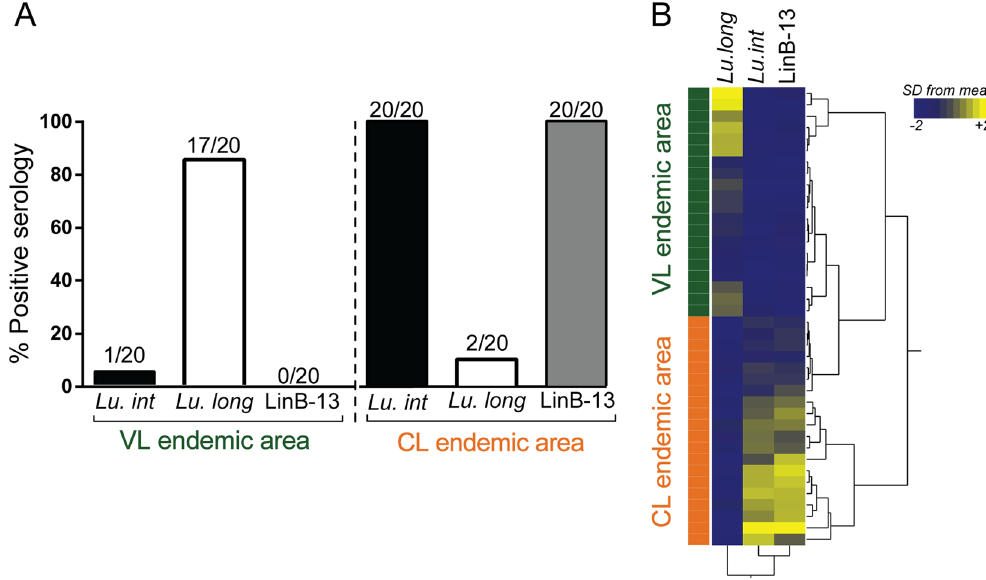
Figure 5. Cross-reactivity between serological responses to LinB-13 and to Lu. longipalpis saliva. Serum samples (n = 20) from residents of a CL endemic or of a VL endemic area were tested by ELISA against Lu. intermedia SGS, Lu. longilpalpis SGS and LinB-13. ( A ) Number of subjects with positive serology to each antigen, comparing the CL and the VL endemic areas. ( B ) Heat map depicting the pattern of Lu. intermedia SGS, Lu. longilpalpis SGS and LinB-13 recognition using Z-score normalized serology.